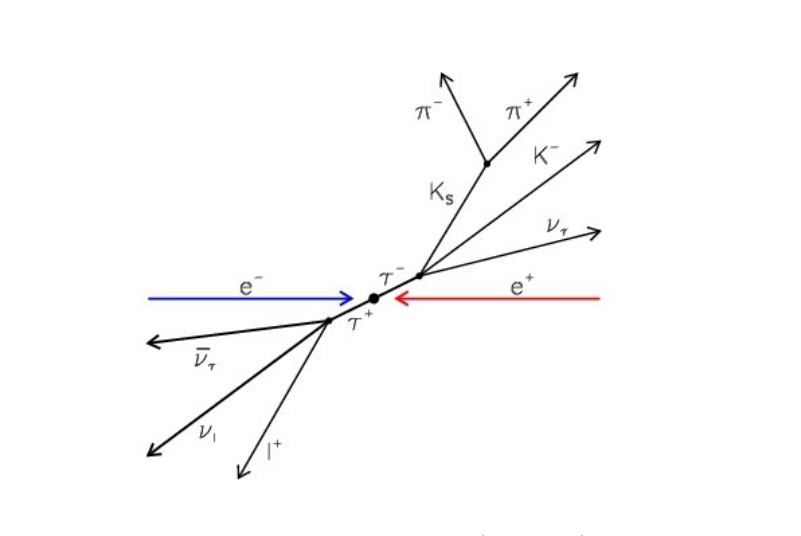
Figure 1: Schematic view of the τ decay chains in e + e − → τ + τ − events selected for this analysis. Lepton l + can be electron or